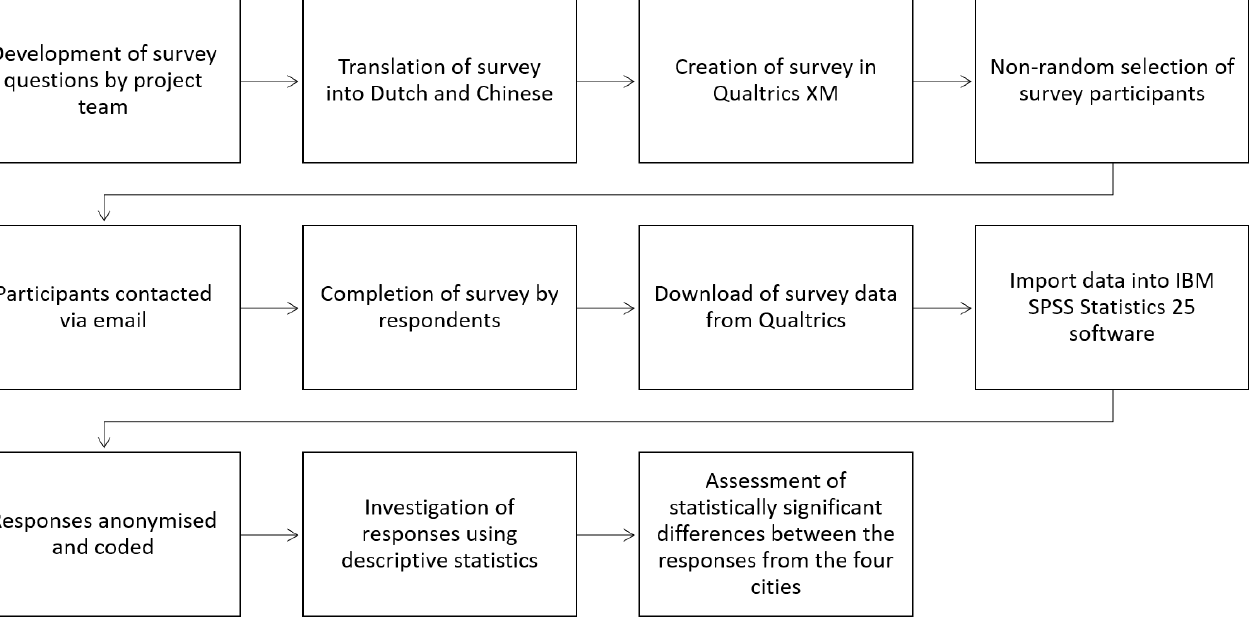
Figure 2. A flow chart summarising the main methodological stages in this study of professional stakeholder perceptions of Blue-Green Infrastructure (BGI).